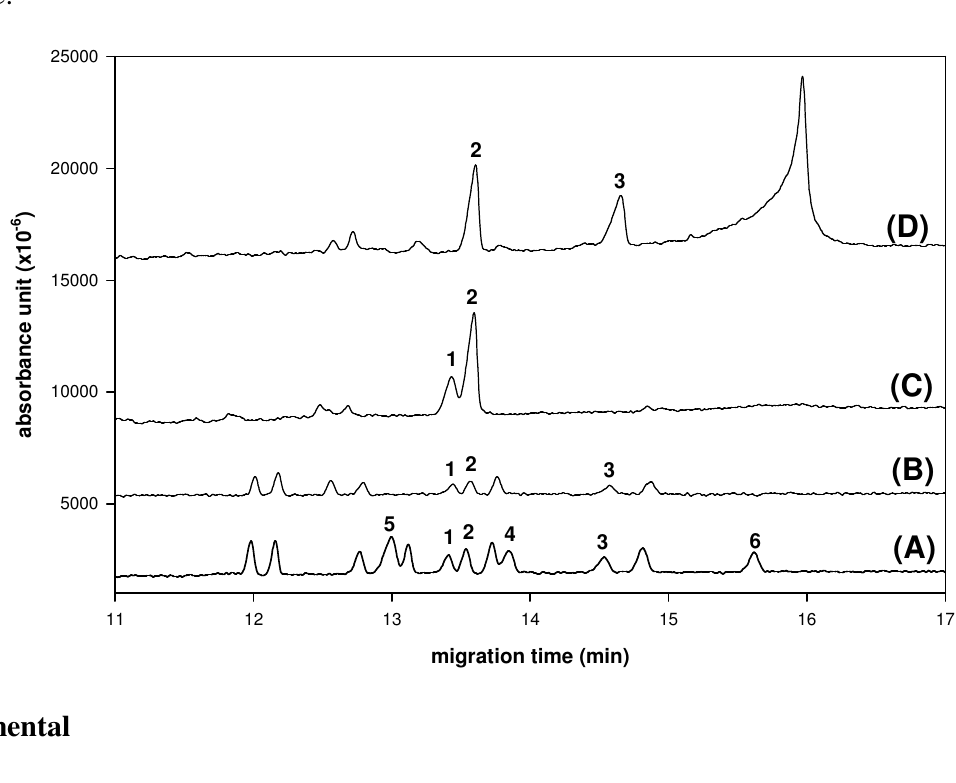
Figure 4. Electrophorograms of composition and configuration analysis of polysaccharide hydrolysate from medicinal herbs. (A) Enantioseparation of D , L pairs of seven kinds of aldo-BINs. (B) Standards of nine D-aldo-BINs for monosaccharide compositional analysis. (C) The polysaccharide hydrolysate from Dendrobium huoshanen. (D) The polysaccharide hydrolysate from Cordyceps sinensis . Peaks: 1 = D -Glc-BIN; 2 = D -Man-BIN; 3 = D -Gal- BIN; 4 = L -Glc-BIN; 5 = L -Man-BIN; 6 = L -Gal-BIN. CE conditions: buffer, 100 mM borate (pH 9.0) contains hydroxypropyl- β -CD (10 mg/mL); applied voltage, 20 kV (detector at cathode side); uncoated fused-silica capillary, 50 cm (effective length) × 50 µ m I.D.; sample injection, 3s by pressure (0.5 psi); wavelength, 254 nm; system temperature, 15